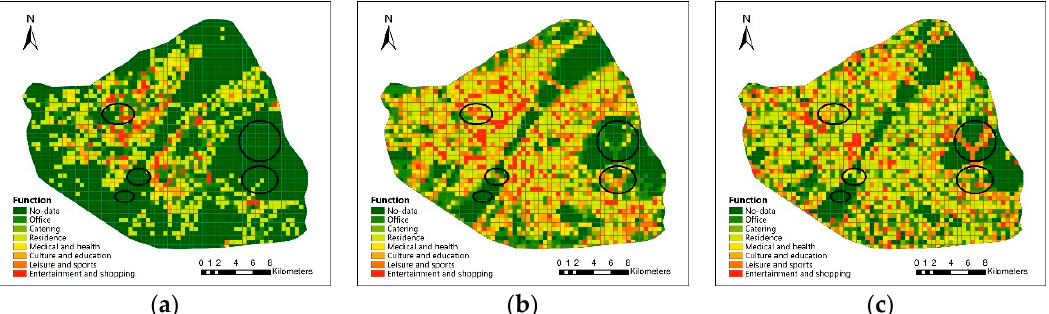
Figure 12. Function recognition results of different methods. ( a ) K-means algorithm ( b ) Word2vec model ( c ) H-LDA model